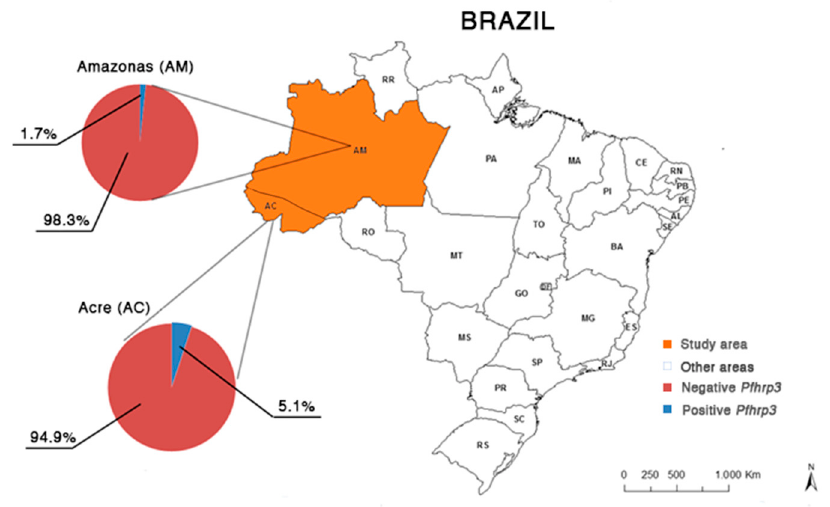
Figure 3. Map of the geographical distribution of the frequency of pfhrp3 -positive and negative P. falciparum isolates observed in the states of Acre ( n = 99) and Amazonas ( n = 60), Brazilian Amazon region. Data: continuous cartographic base of Brazil of 2015; Brazilian Institute of Geography and Statistics (IBGE) .